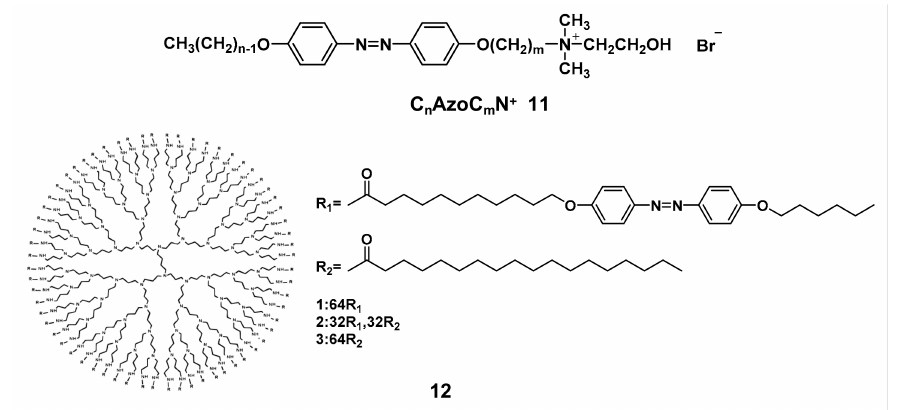
Figure 10. Molecular structure of azobenzene derivatives 11 and dendrimer azobenzene 12